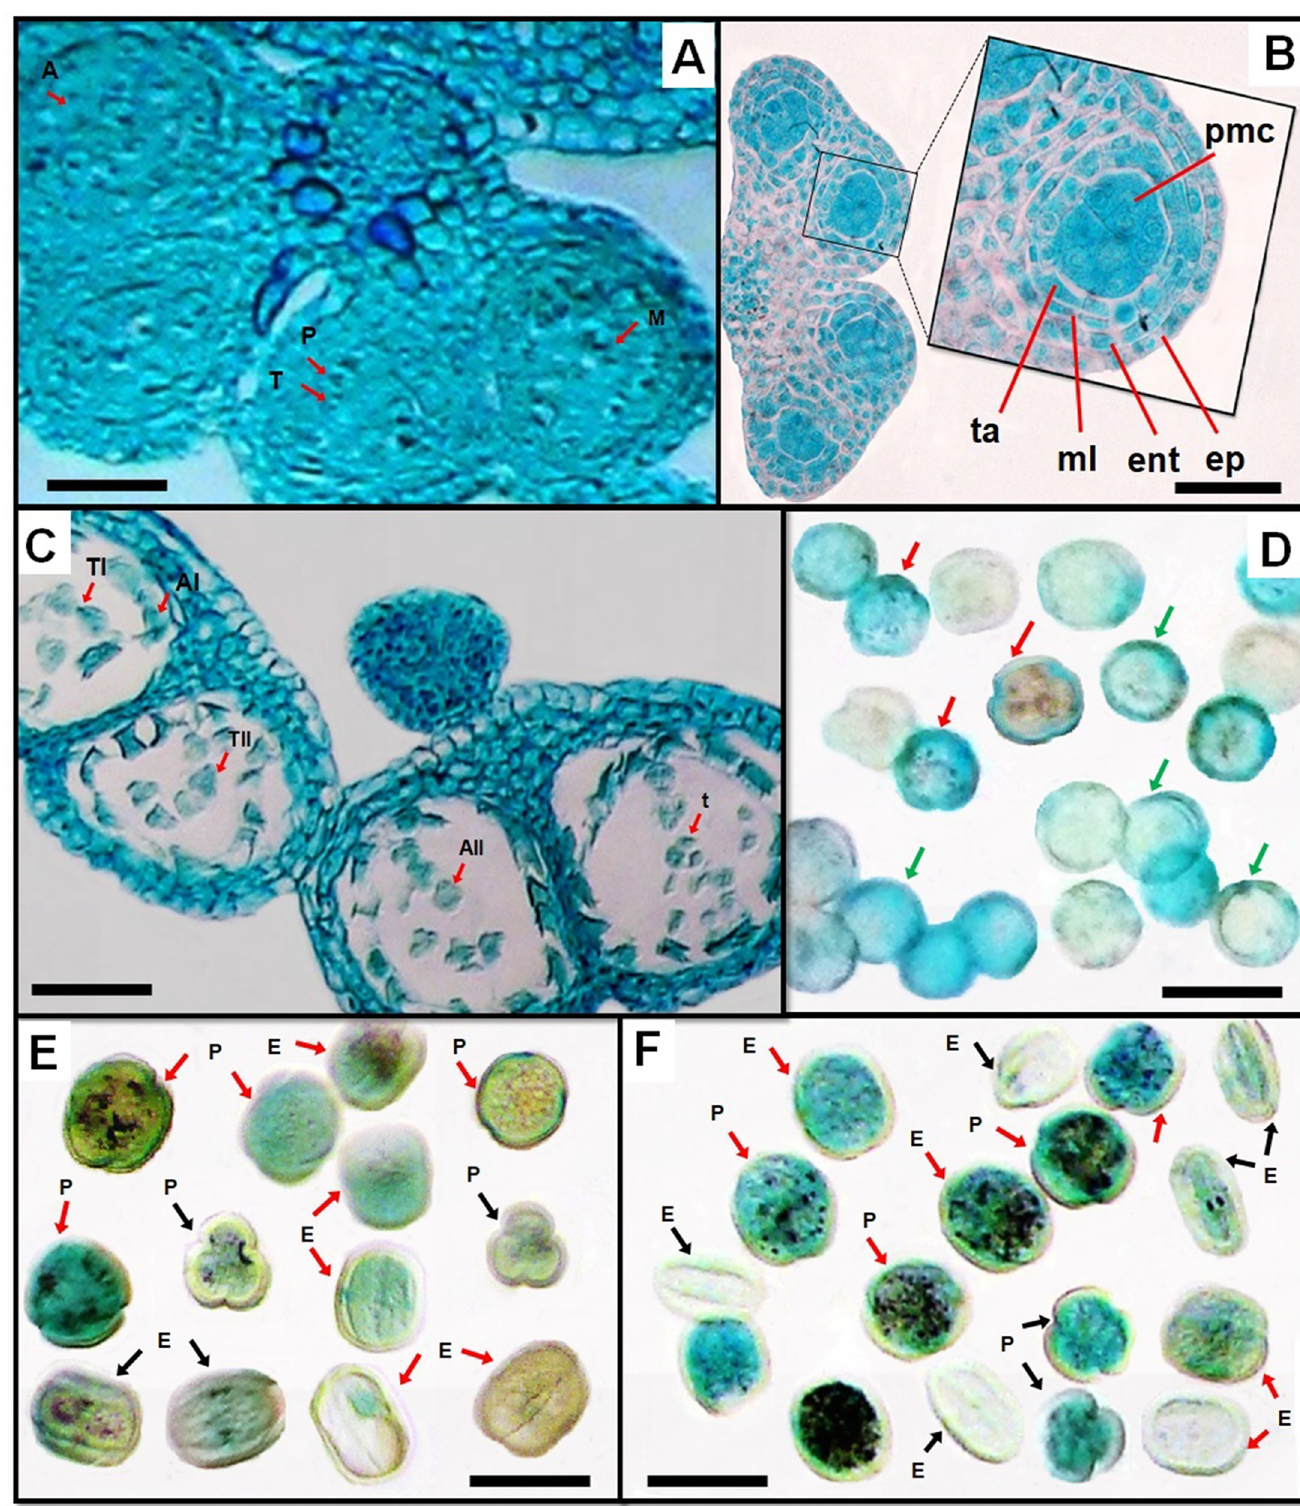
Fig 2. Anther wall formation, microsporogenesis, microgametogenesis and morphology of pollen grains of Polygonum . A, Cross-sectional view of anther, showing a row of secondary sporogenouscells gave rise to a mass of microspore mother cells by several mitotic divisions (arrow). B, Anther wall formation. C, Microsporocytes cells at anaphase I, telophase I, anaphase II and telophase II (arrow). Pollen morphology of P . maritimum (D), P . aviculare (E) and P . equisetiforme